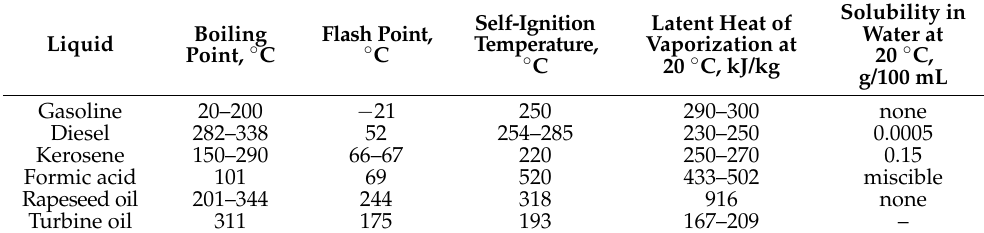
Table 6. Main characteristics of highly flammable liquids